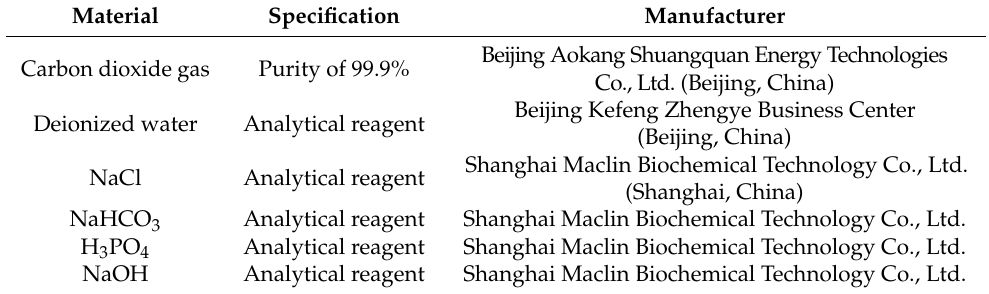
Table 2. Major instruments and